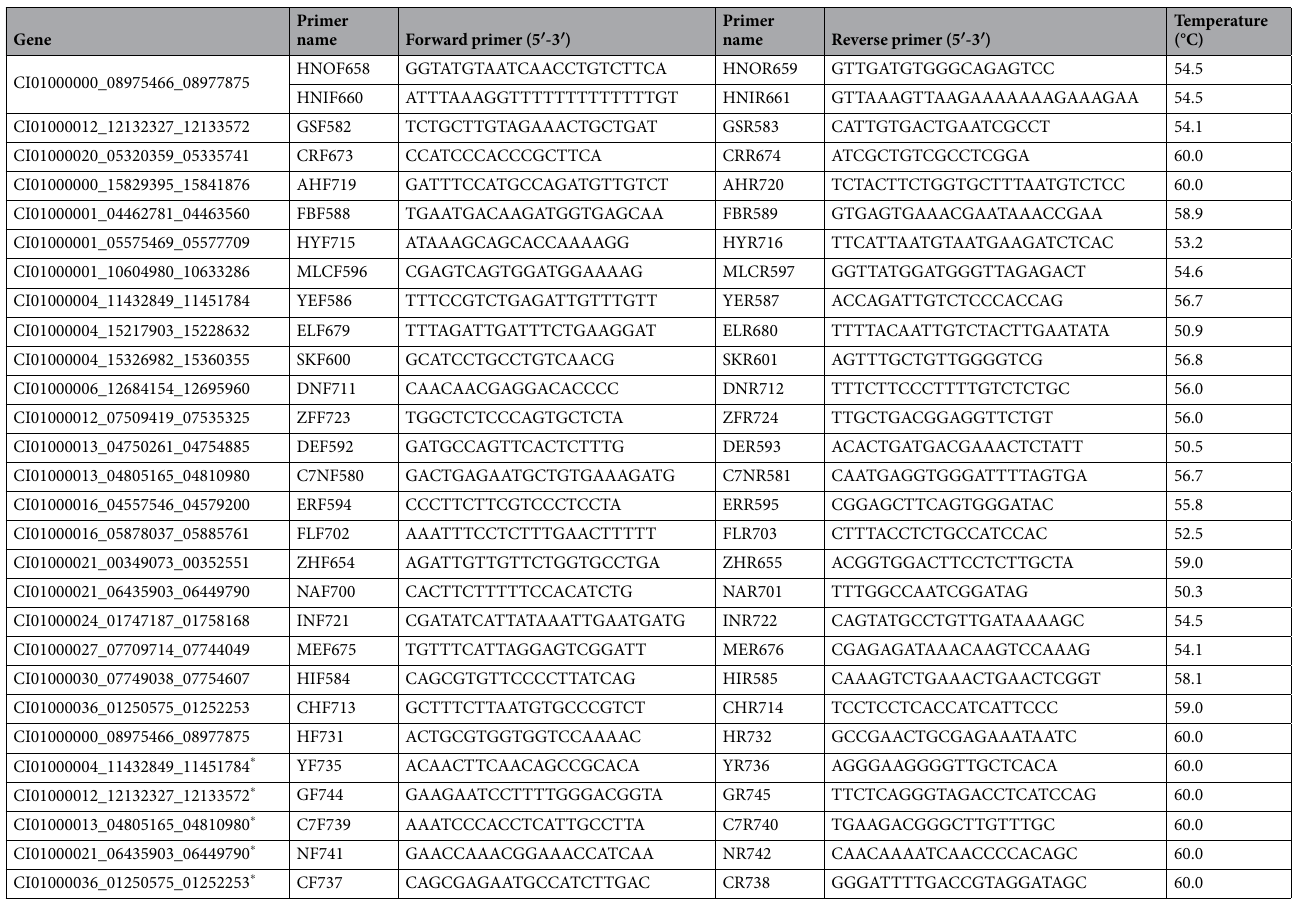
Table 2. Primers used in the experiment. Note: * Indicates the primers used in the qRT-PCR, other primers are used in the SNPs